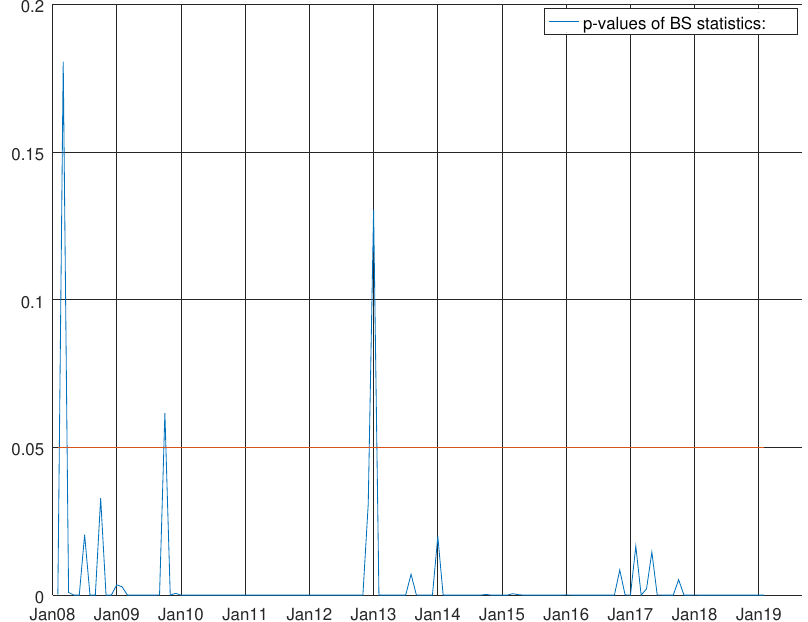
Figure 9. Graph showing the p -values of the Durbin–Watson test for the VARMA model using both hard and soft data for non-durable goods. The null hypothesis states that residuals are not autocorrelated.